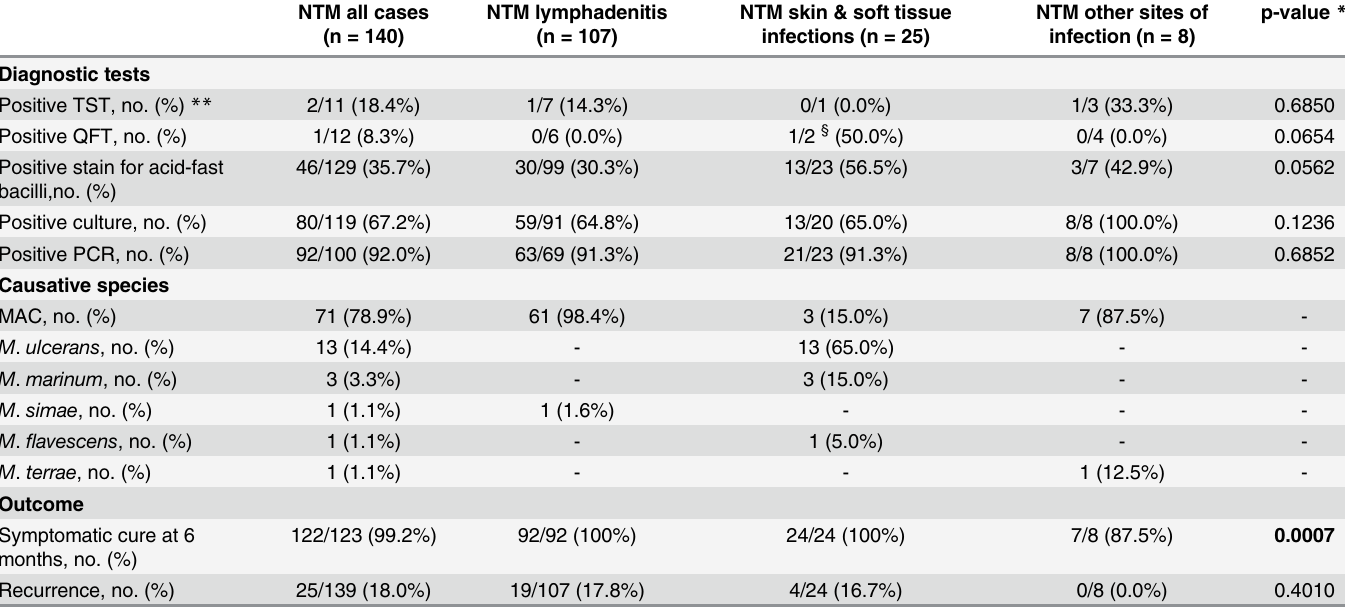
Table 2. Results of diagnostic tests for mycobacterial infection, causative species and outcome in the three groups with nontuberculous myco- bacterial disease. NTM all cases (n =